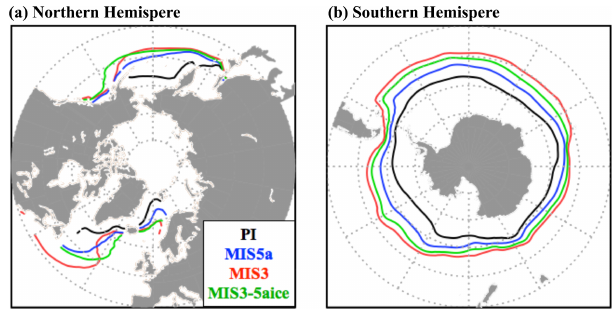
Figure 4. Annual mean sea ice coverage simulated from the AOGCM. The coverage is defined by a 15% sea ice concentration. A 100-year average is used. Panel (a) shows the Northern Hemi- sphere, and panel (b) shows Southern Hemisphere. Black represents PI, blue represents MIS5a, red represents MIS3, and green repre- sents